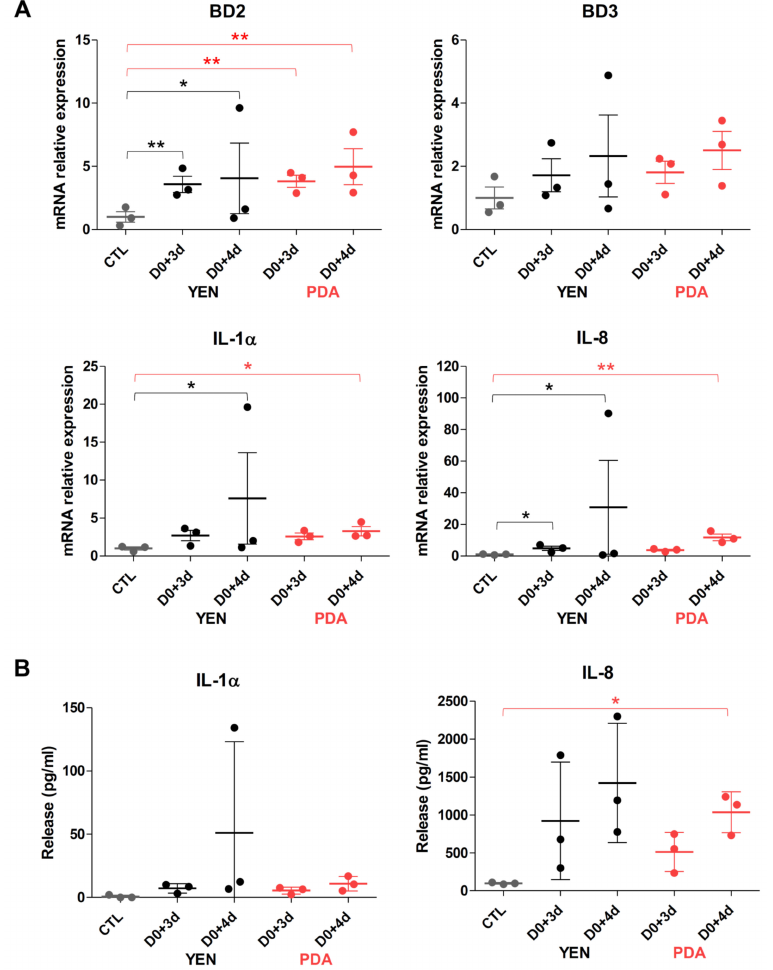
Figure 5. Keratinocytes responses during T. rubrum IHEM 13894 infection on reconstructed